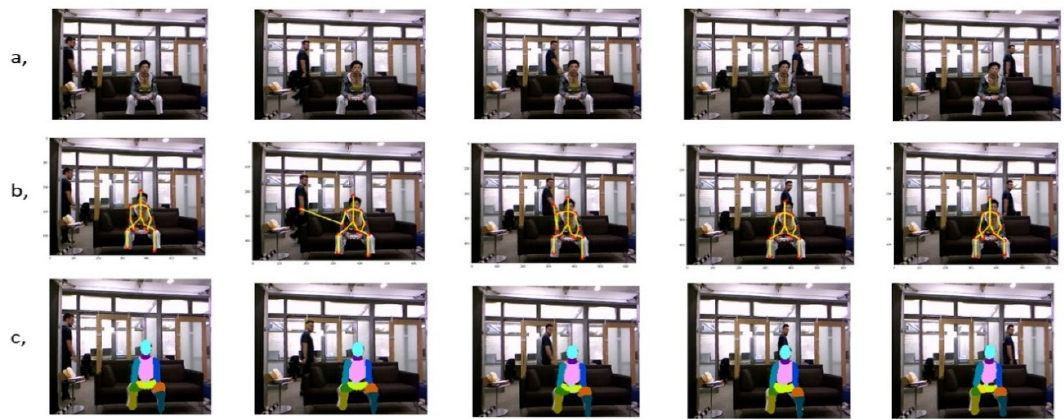
Figure 1. Illustration of the case in which many actors are present in the scene. The first row ( a ) RGB input images, the second row ( b ) extracted skeleton joints images, and the last row ( c ) color-encoded body part segmentation images. In this case, the skeleton joints extraction can be distracted by other objects in the background, but the color-encoded body part segmentation can help avoiding such a case.